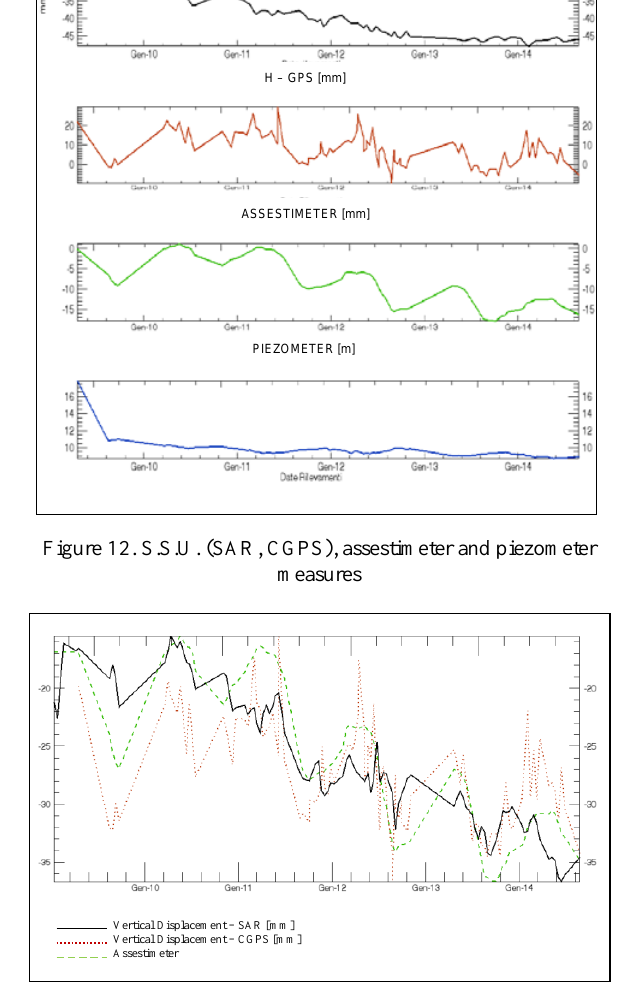
Figure 13. Normalized overplot among the time series of the assestimeter, CGPS and SAR vertical component measures Superficial assestimeter is able to measure the land Figure 11. SAR Amplitude Image, S.S.U. response. On the left before the corner reflectors installation, on the right after corner reflectors installation